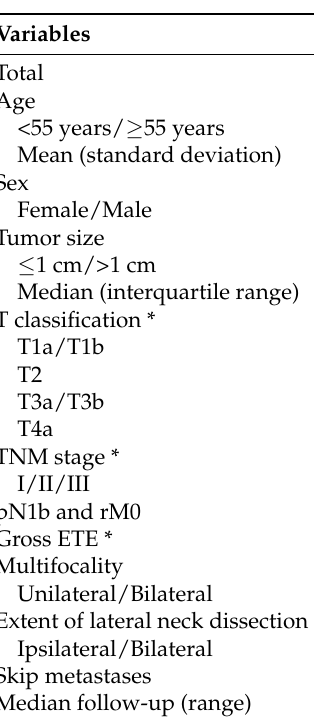
Table 1. Patients’